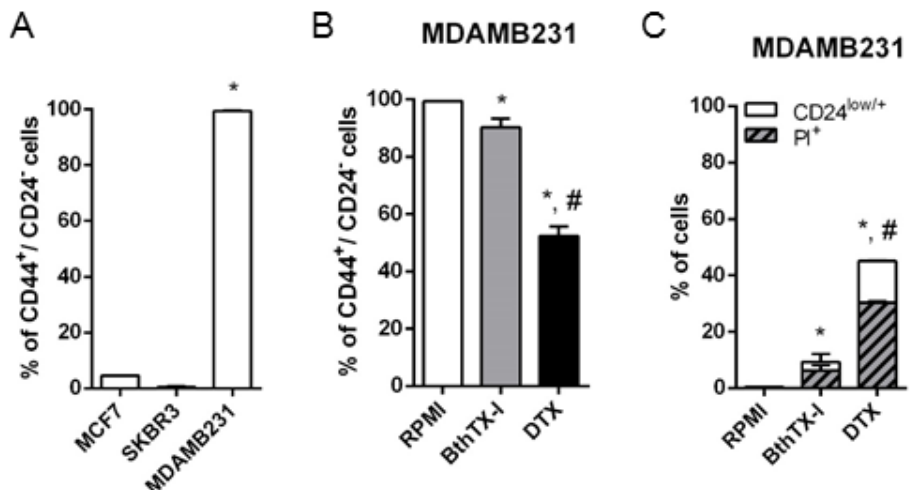
Figure 5. Quantification of cancer stem cells. The CSCs immunophenotyping quantification was carried out by flow cytometry using propidium iodide staining of the biomarkers CD24 and CD44. ( A ) Percentage of CD44 + /CD24 - cancer stem cells in untreated breast cancer cell lines. ( B ) Percentage of CD44 + /CD24 -/low cancer stem cells in the MDAMB231 cell population treated with BthTX-I at 102 µg/mL for 24h. ( C ) Expression of CD24 + cells in the cell population depicted in ( B ). DTX: cells treated with 20 µM N-desmethyltamoxifen (positive control). RPMI: cells incubated in estrogen-free RPMI 1640 medium supplemented with CS-FBS (negative control). PI: Propidium iodide staining. Values represent mean ± SD of at least three independent experiments. p < 0.05 vs. *negative control and vs. # BthTX-I (Student’s t